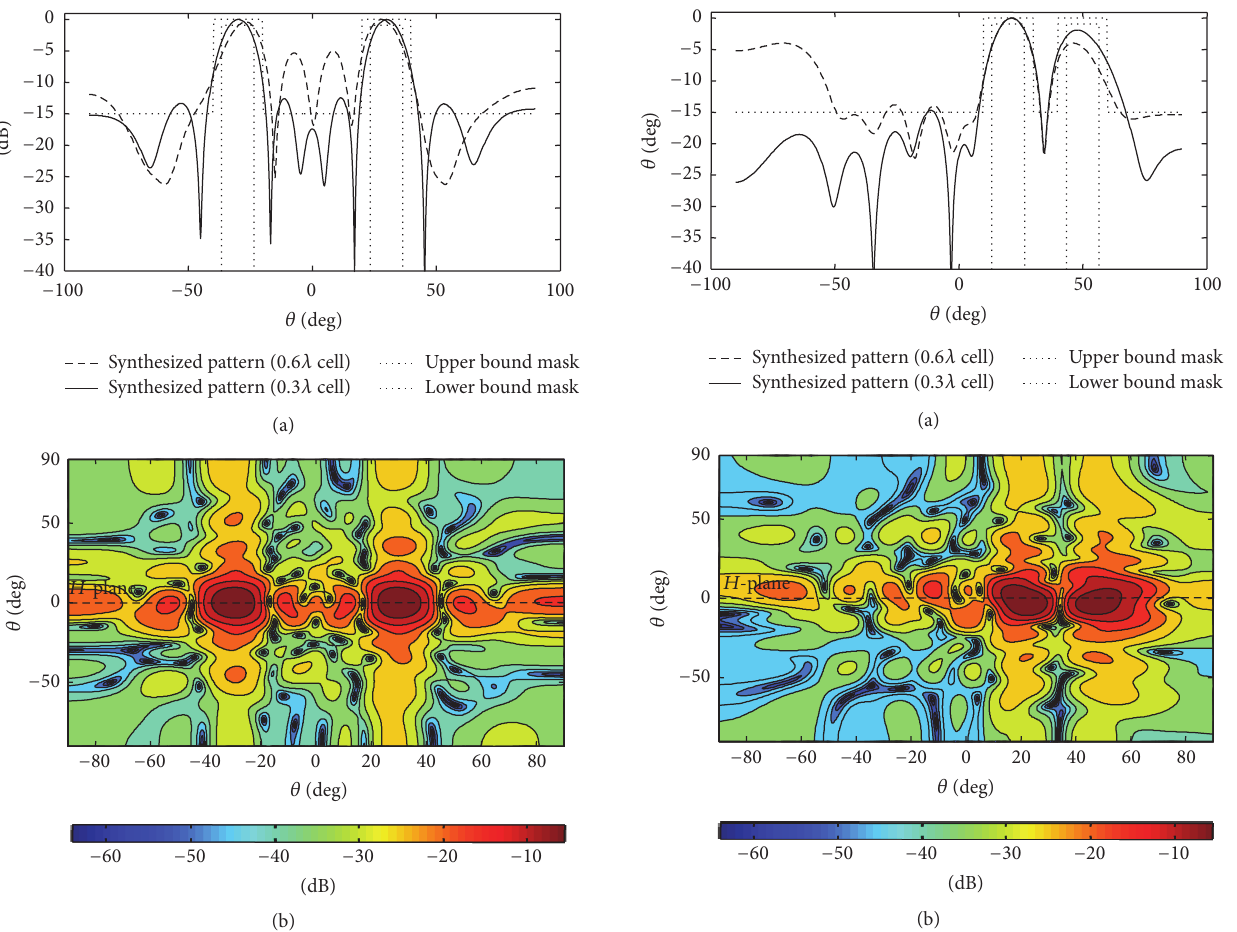
Figure 22: Design #2 : (a) synthesized 𝐻 -plane array factor; (b) synthesized 𝐸 -field contour plot.